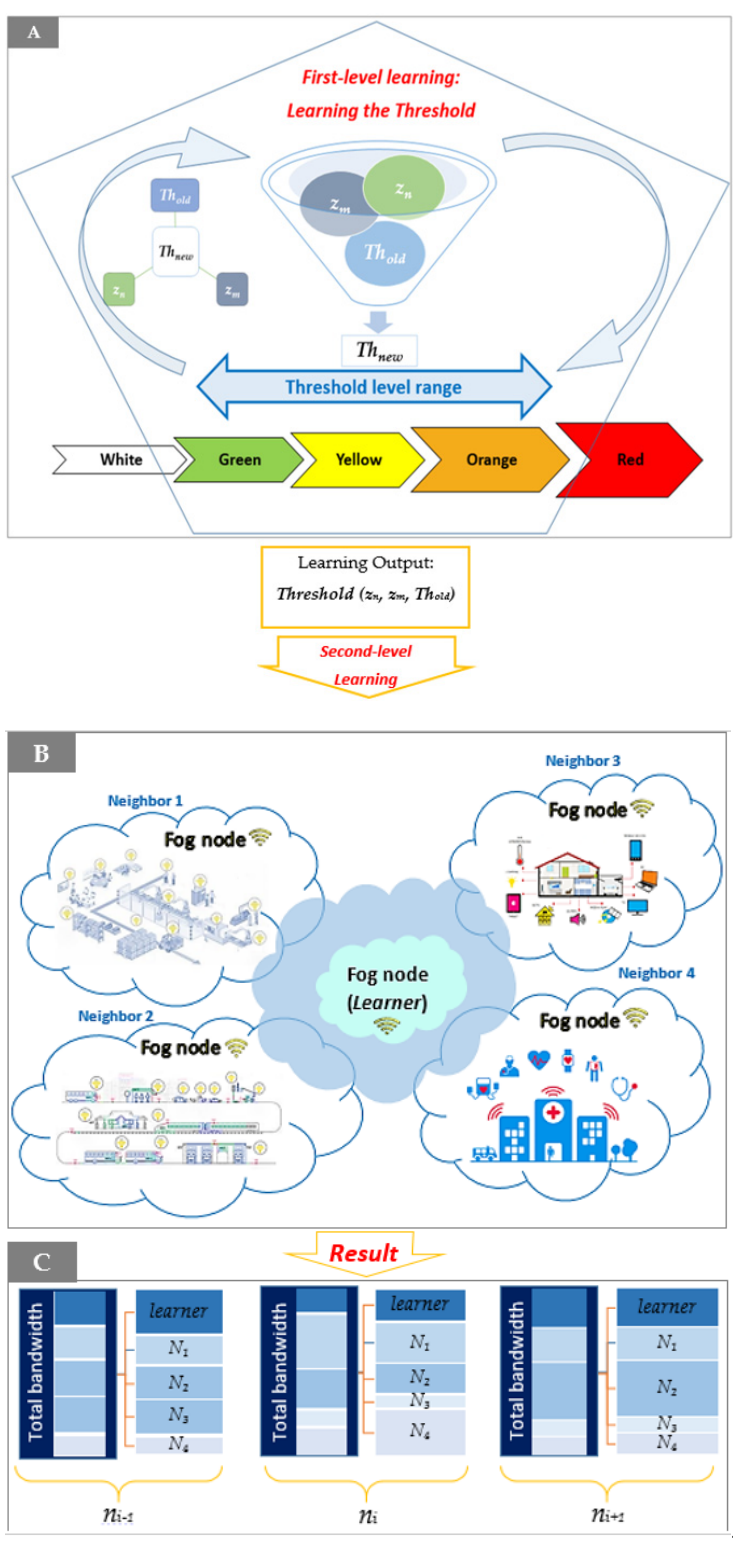
Figure 1. Illustration of the two-level learning hierarchy in which ( A , B ) denote the first (lower) and second (higher) learning hierarchy levels. The second learning level uses the final threshold matrix, the result of the first level after convergence. (Part C ) presents the amount of each fragment’s bandwidth during three consecutive time